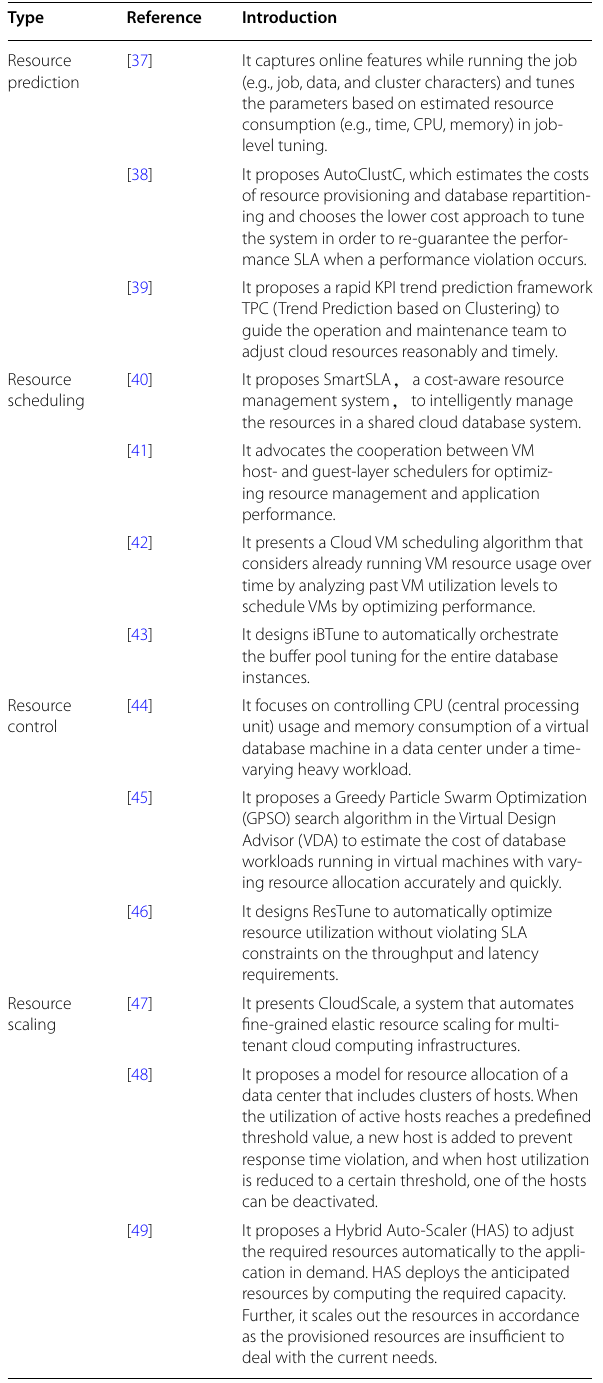
Table 3 Studies about AI empowered resource management Table 4 The relevant quotations extracted from